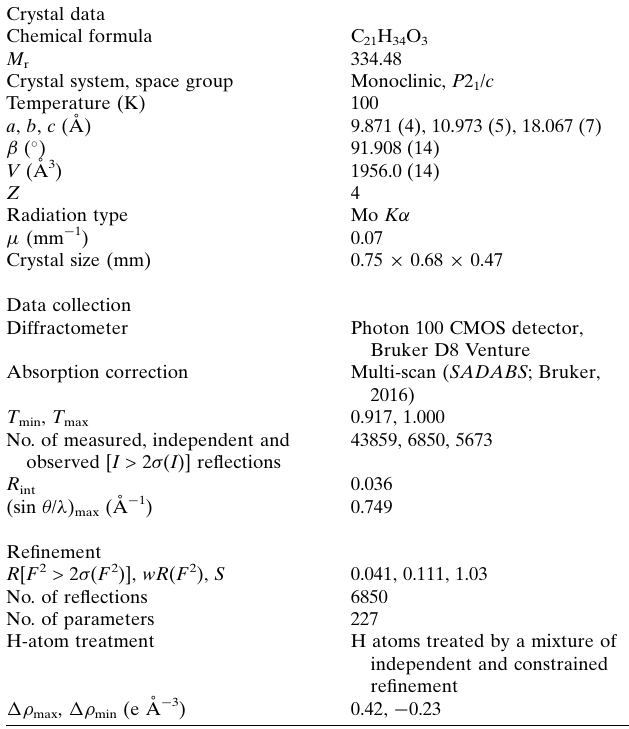
Table 3 Experimental details. Crystal data Chemical